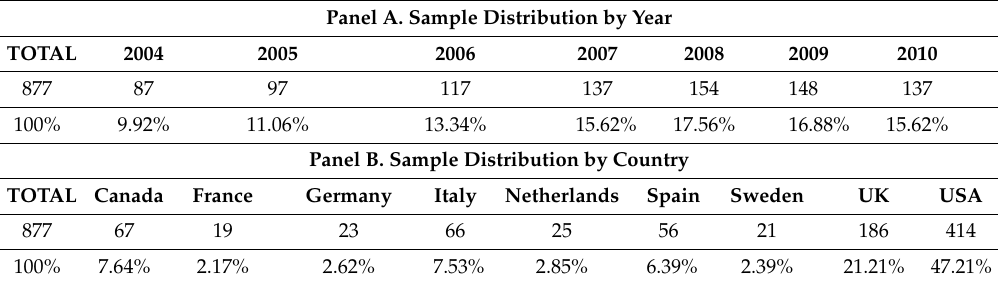
Table 1. Sample distribution by year and